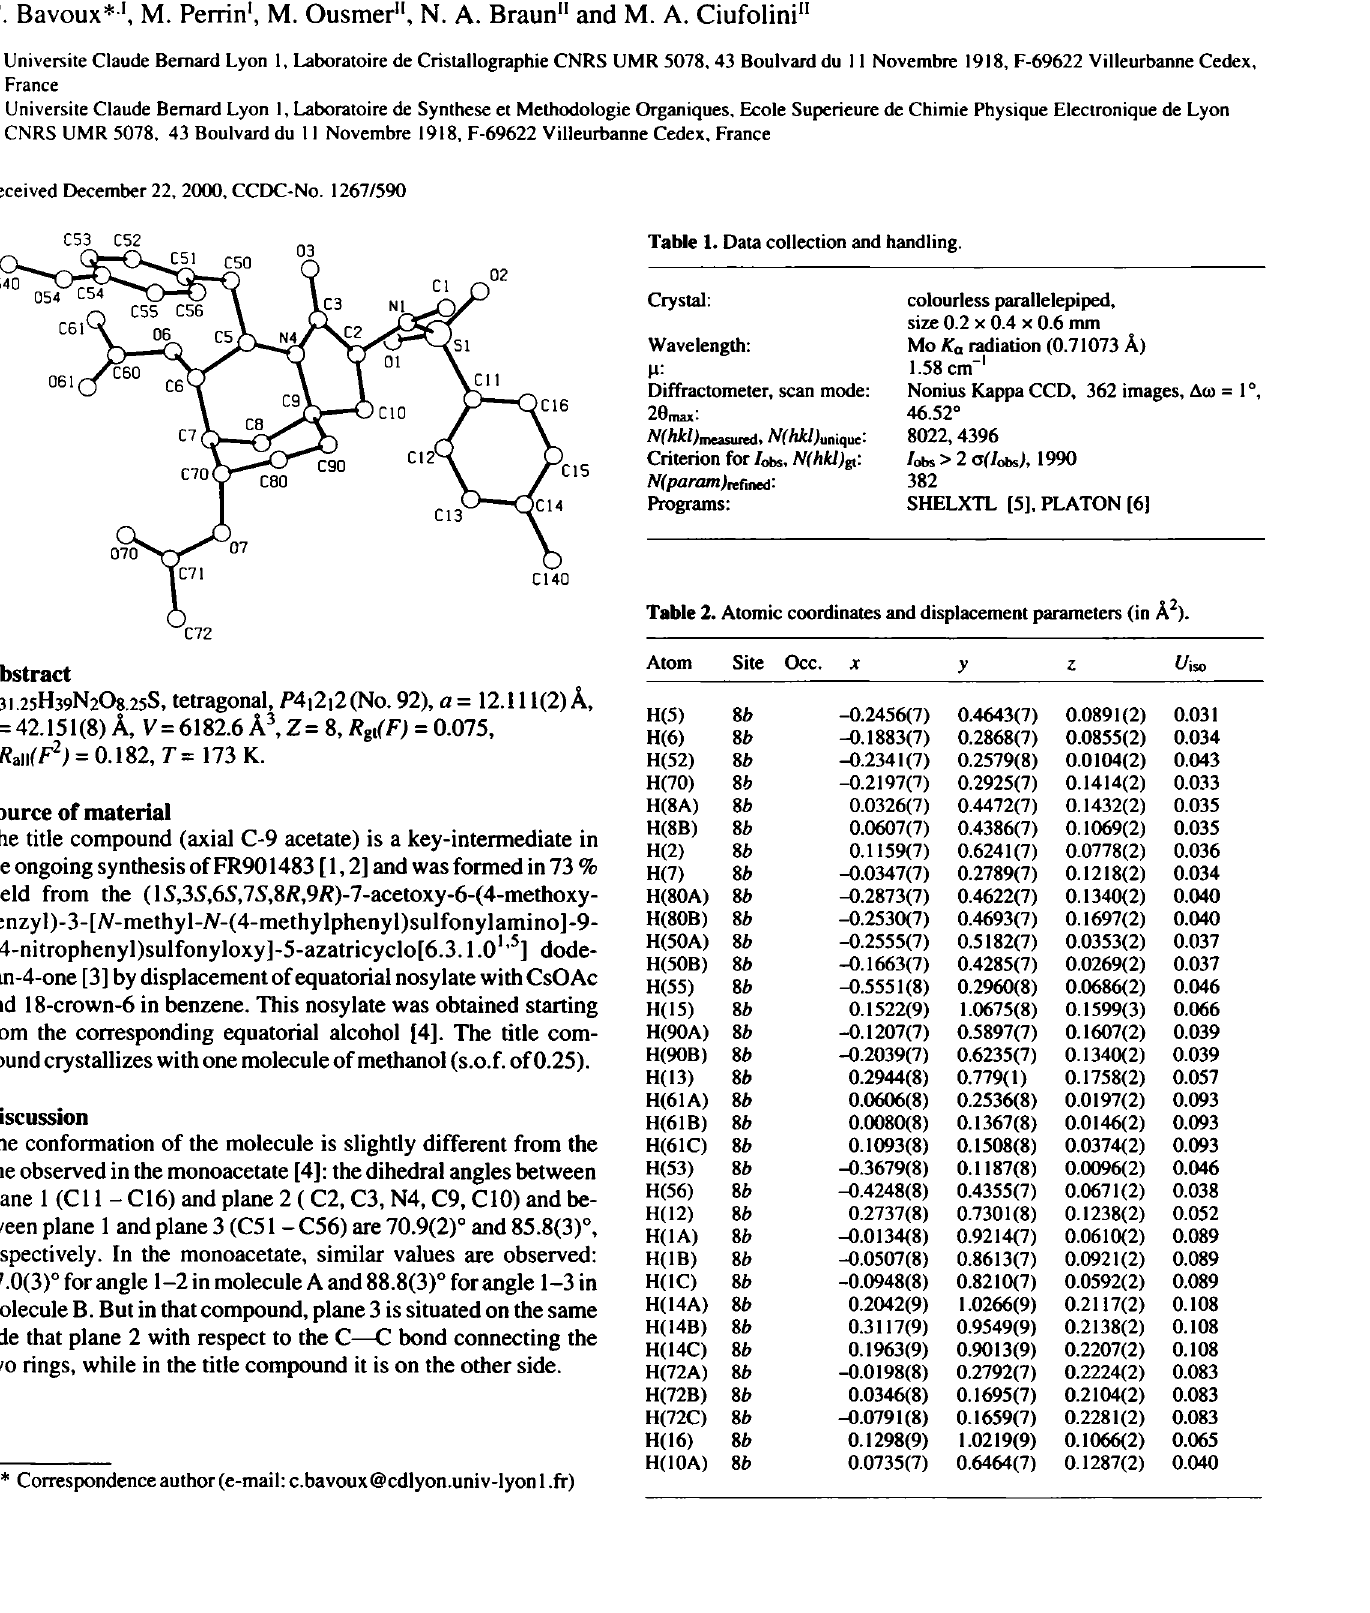
Table 2. Atomic coordinates and displacement parameters (in A 2